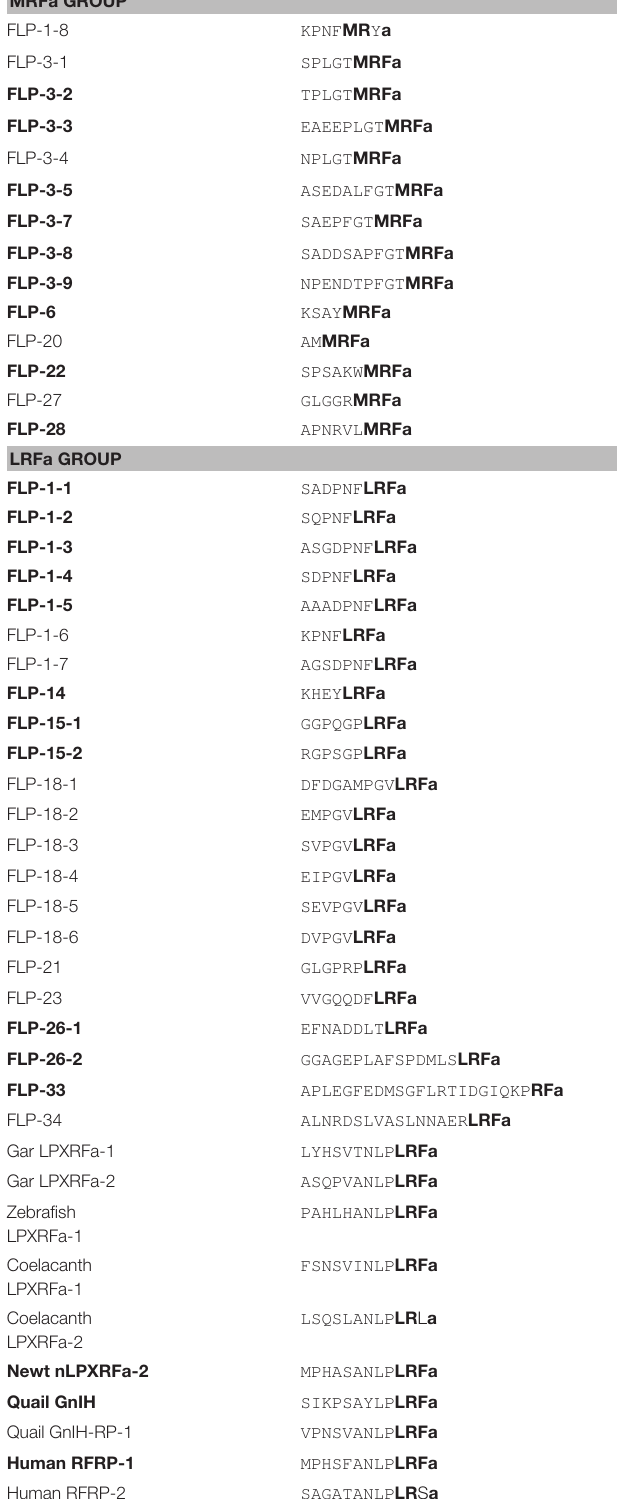
TABLE 4 | Grouping of GnIH (LPXRFa) peptides of chordates and FLPs of C. elegans